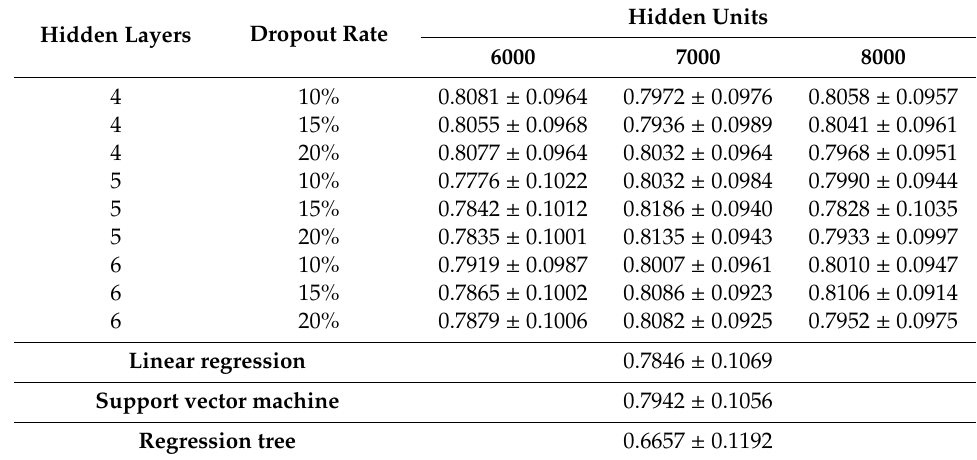
Table 3. The Pearson correlation coe ffi cient (PCC) of LR, RT, SVM, and D-GPM, with partially di ff erent architectures (hidden layer: from 4 to 6, with step size 1; hidden unit: from 6000 to 8000, with step size 1000; dropout rate: from 10% to 20%, with step size 5%) for MBV-te. The numbers before “ ± ” are the overall PCC for all the target genes. The numbers after “ ± ” are the standard deviations of the PCC over all the target genes. The best PCC performance of D-GPM is underlined. SD refers to the standard